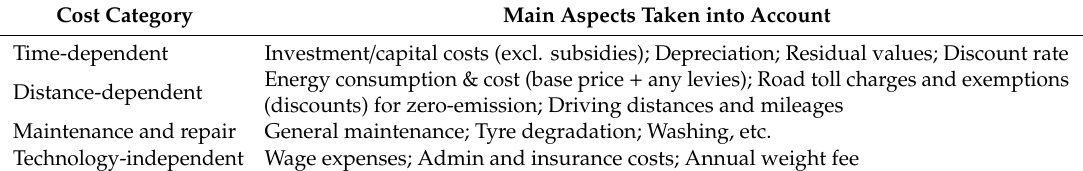
Table 1. Overview of main cost aspects considered in the cost-comparison model. All cost comparisons exclude VAT, since firms can subtract this on incoming goods and services. Exchange rate used: 1 EUR = 9.8